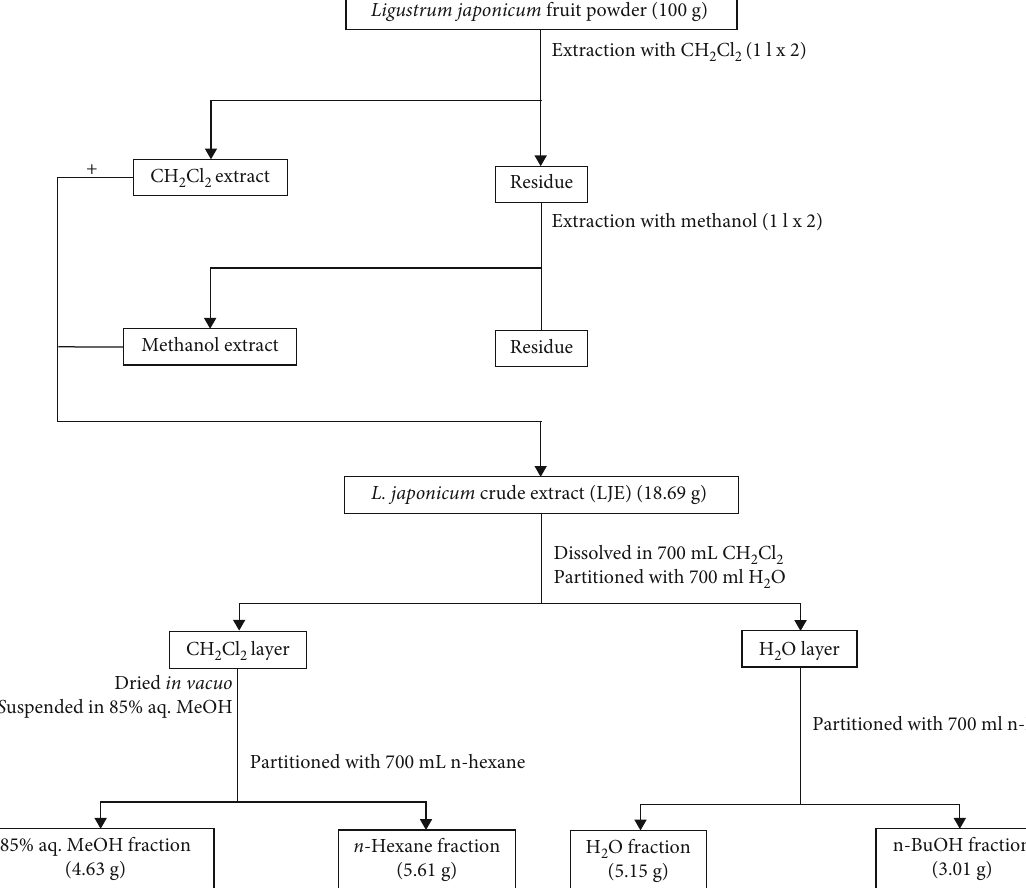
Figure 1: Extraction and solvent fractionation of Ligustrum japonicum Thunb.